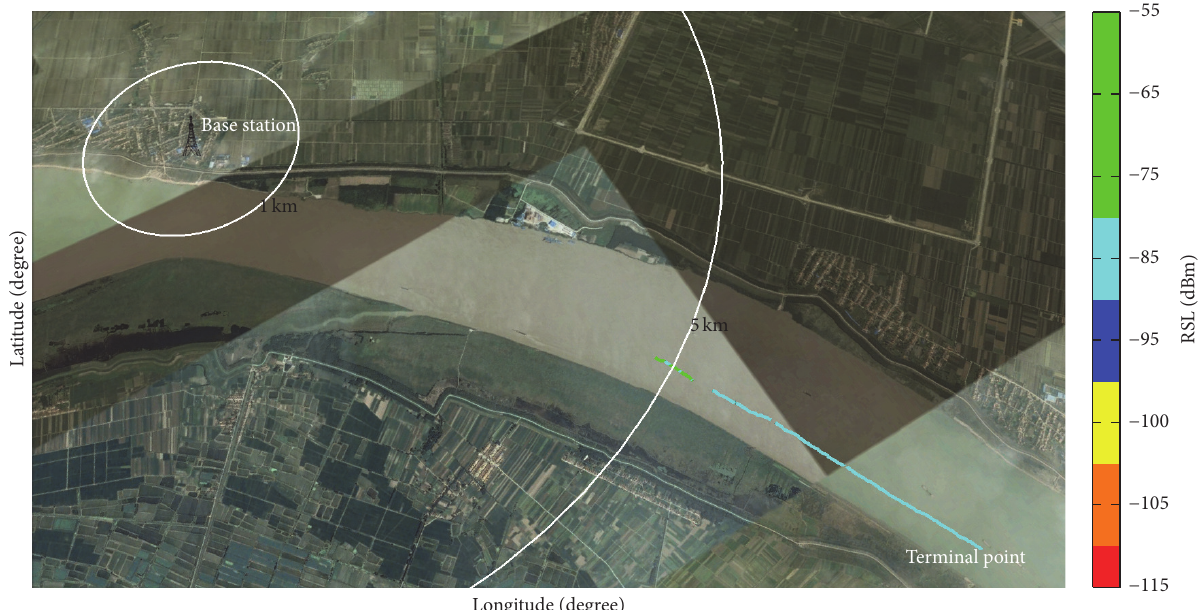
Figure 7: The route of suburban measurement